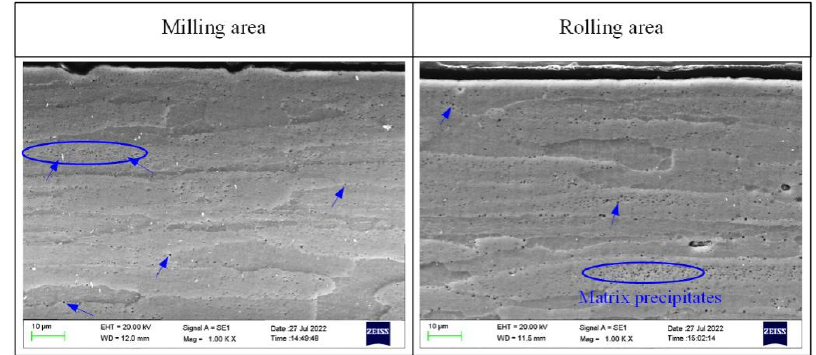
Figure 10. SEM morphology of the milling area and rolling area of the T1 sample after rolling correction only.